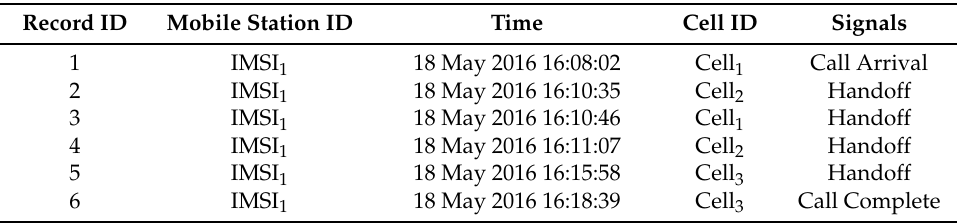
Table 1. The cellular network signals during a call performed by IMSI 1 on 18 May 2016.